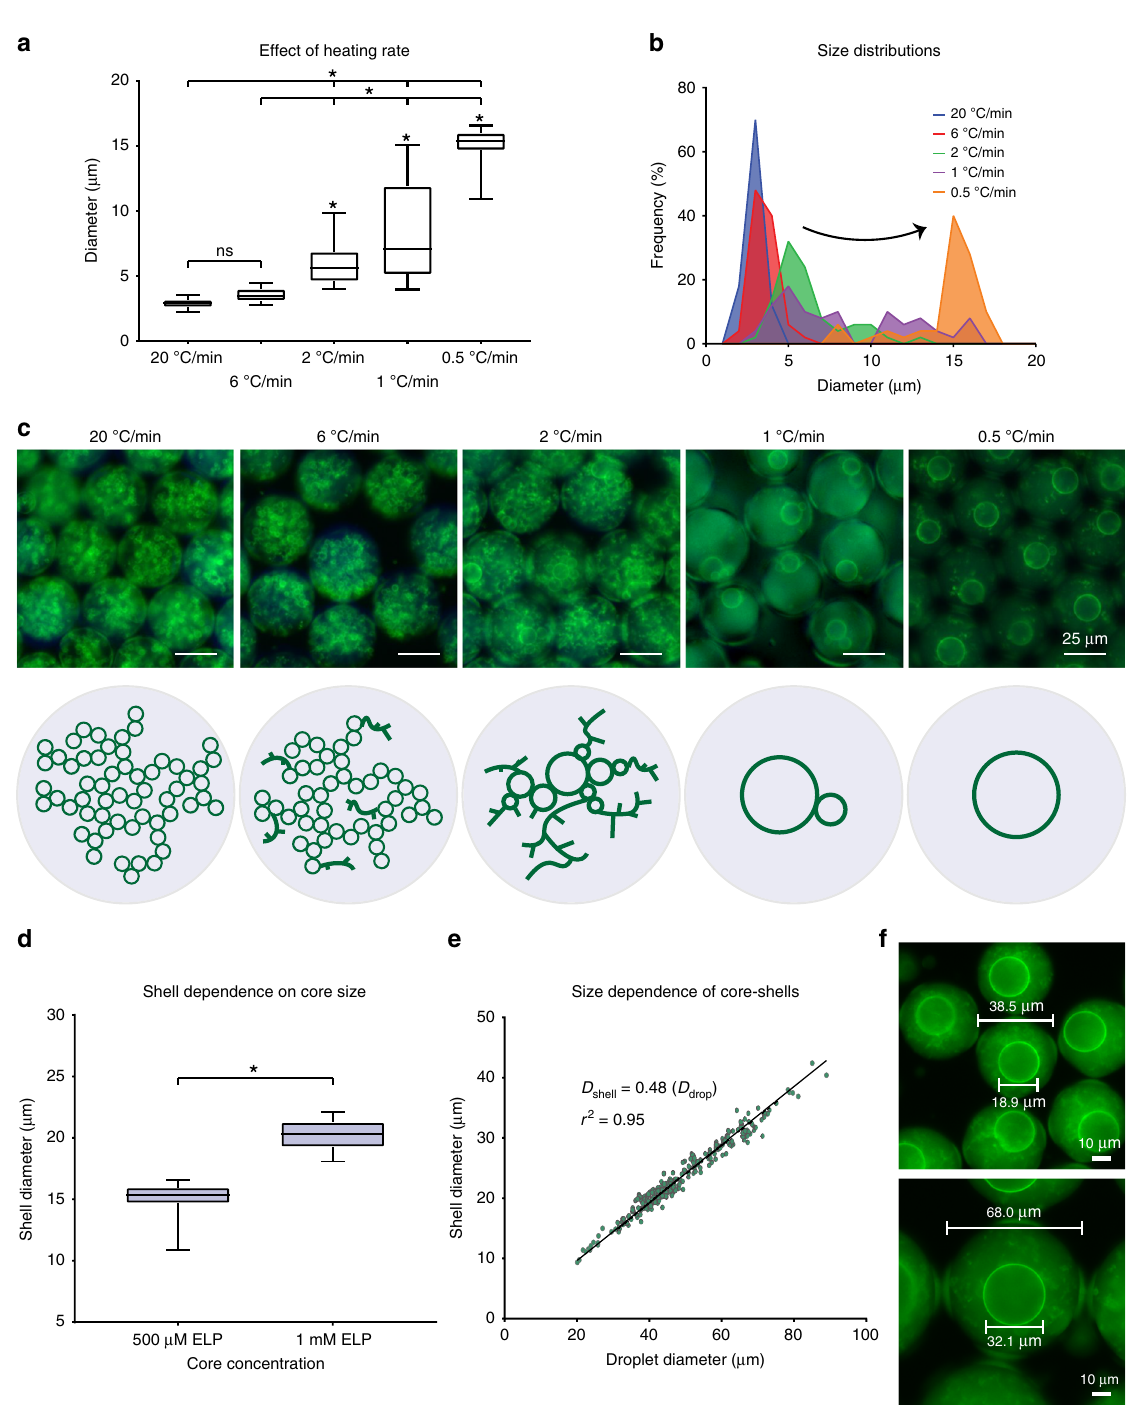
Fig. 3 Controlling hollow shell architecture. a Size distribution of xPOP shells formed after heating a mixture of ELP(V) (1 mM) + xPOP(V 1 A 4 )-12.5% (100 µ M) at different constant rates (10 – 90% box and whiskers plot with median central line bounded by 25 and 75% quartiles, * p < 0.05 as determined by one-way ANOVA with Tukey ’ s post hoc test, n = 50 shells measured using 3D confocal image stacks for each rate). b Histogram of the size distribution of the xPOP shells shows a broad distribution of shell diameters at ramp rates > 1 °C, the development of a bimodal distribution at 1 °C/min, and emergence of a unimodal size at 0.5 °C/min. c Fluorescence microscopy images and corresponding cartoon of the hollow xPOP shell architectures that form at different heating rates. The system shifts from a network of interconnected hollow shells to a single hollow protein shell as the heating rate is slowed. d Hollow xPOP protein shell diameter increases with increased ELP concentration (10 – 90% box and whiskers plot with median central line bounded by 25 and 75% quartiles, * p < 0.01 as determined by two-tailed Students t -test, n = 50 droplets for each rate). e Linear regression analysis for a polydisperse mixture of ELP(V) (1 mM) + xPOP(V 1 A 4 )-12.5% (100 µ M) comparing diameter of the water-in-oil emulsion droplets with the diameter of the xPOP shells contained within the droplets ( n = 280 droplets). f Typical fl uorescence images illustrating the linear correlation between droplet diameter and xPOP shell diameter and the ~0.5 scaling pre-factor that relates droplet diameter to xPOP shell diameter. Source data for are provided as a Source Data fi